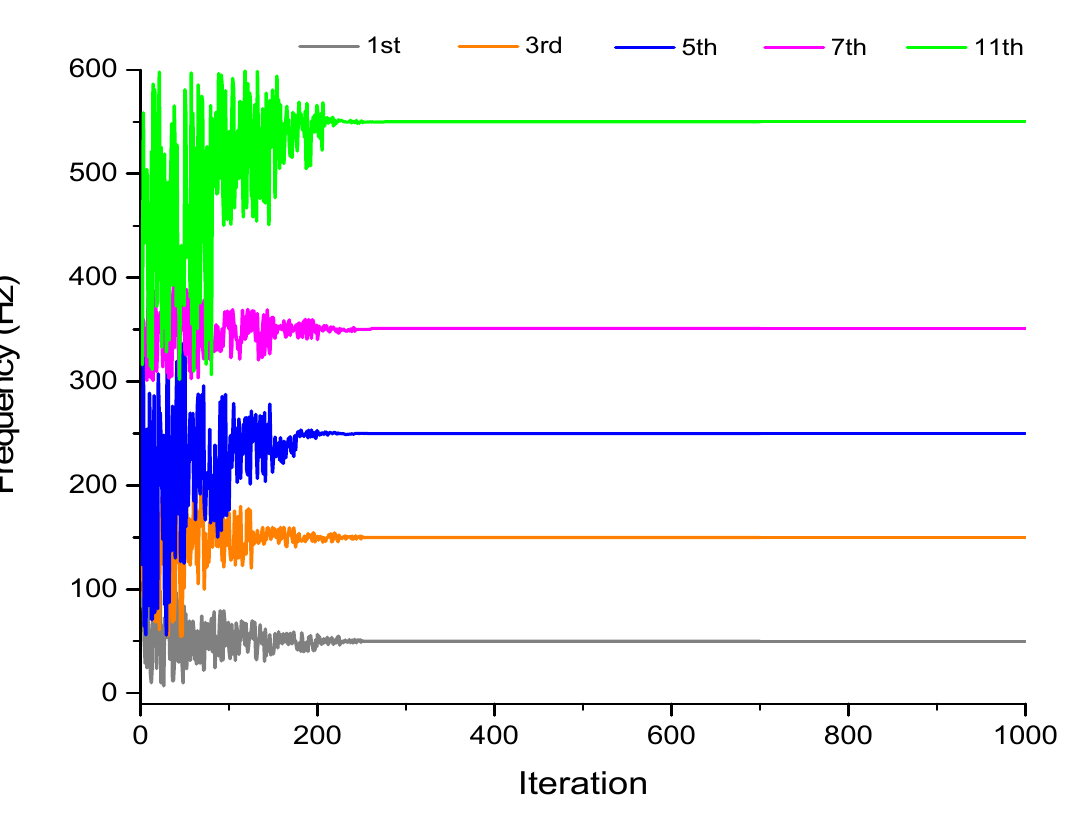
Figure 11. Frequency estimation for case study I.